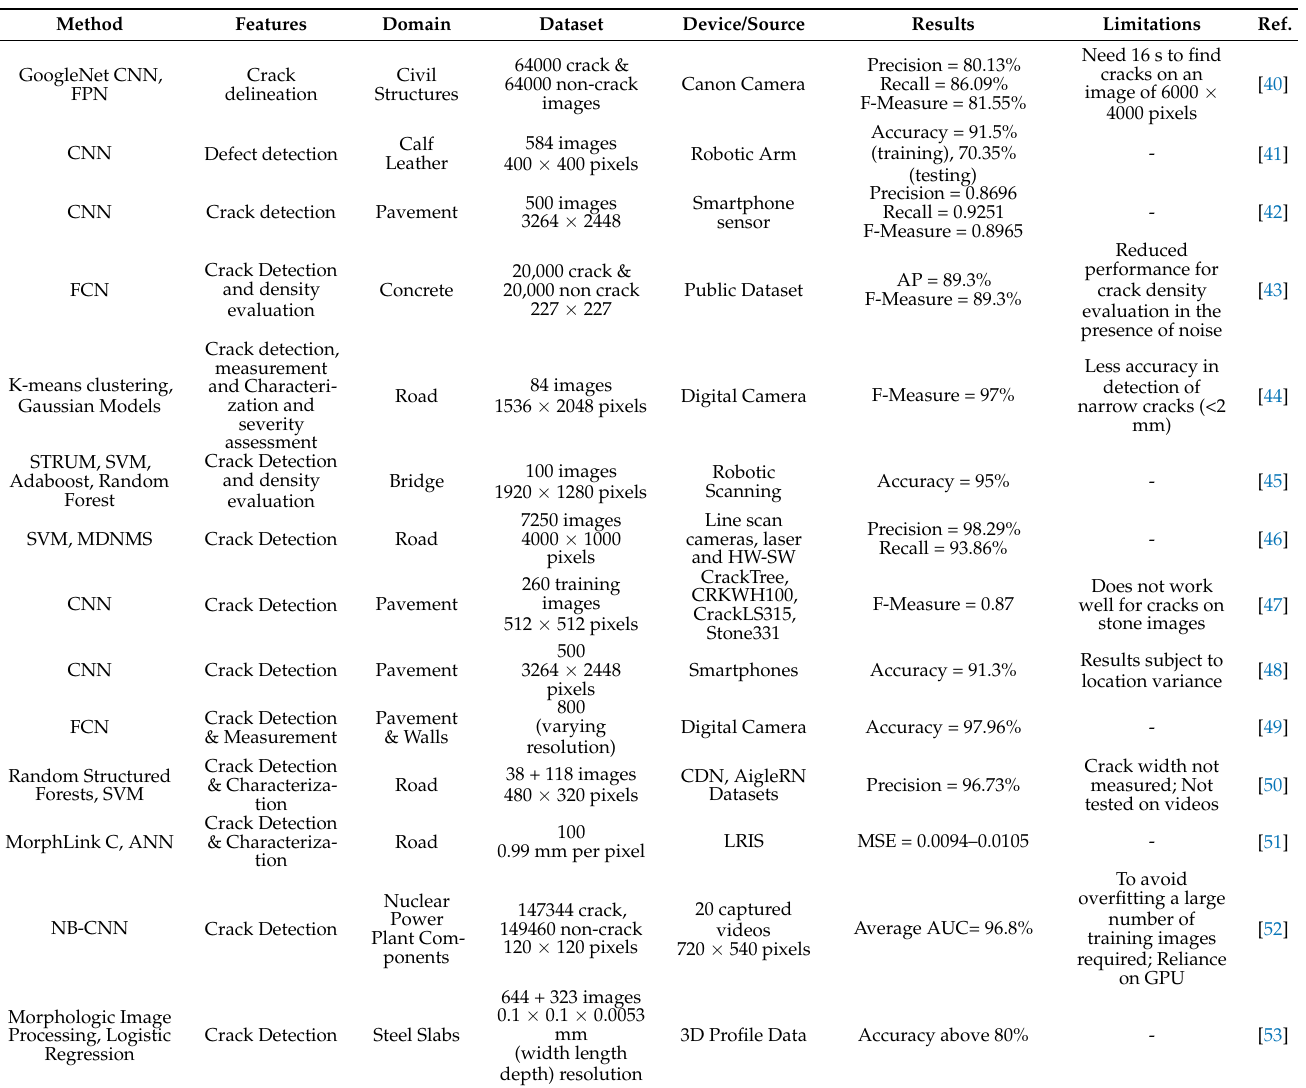
Table 2. Machine Learning-based Crack